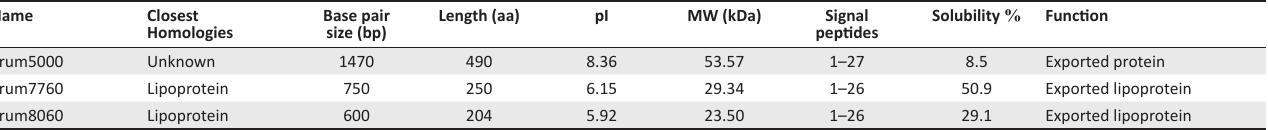
TABLE 1: Summary of results obtained from the selection of vaccine candidates using bioinformatics